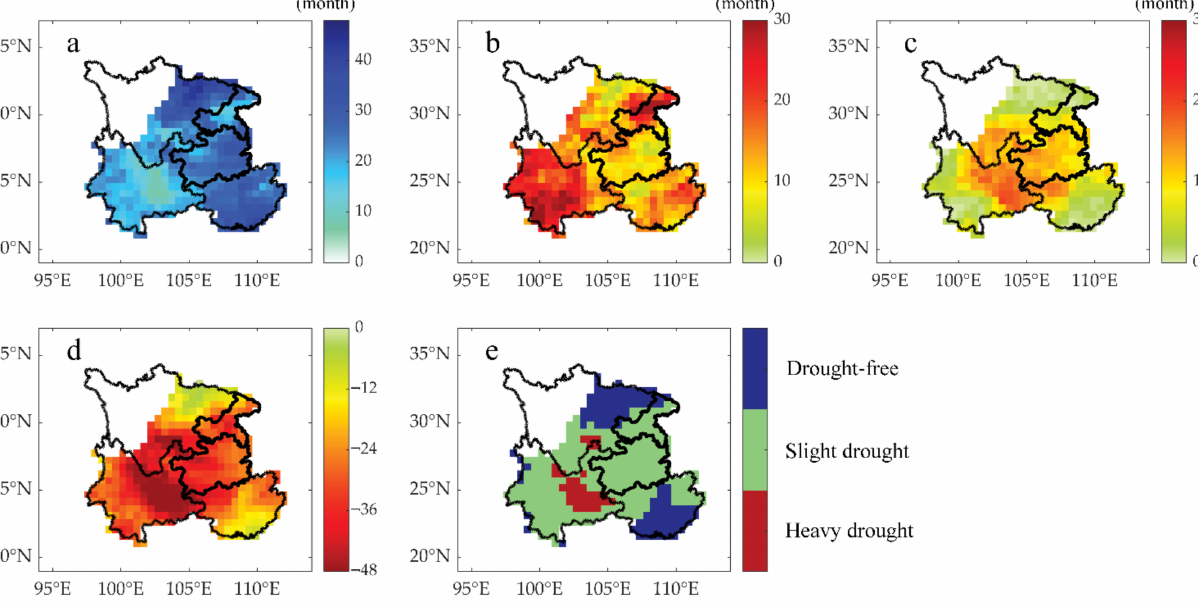
Figure 4. The drought situation identified by SPEI06 in SWC from 2009 to 2012; ( a – c ) are the drought situations identified by the first threshold method, indicating the number of months with no drought, slight drought, and heavy drought, respectively; ( d ) is the SPEI06 value of the second threshold method; ( e ) is the severity of drought—red, green, and blue indicate heavy drought, slight drought, and no drought,